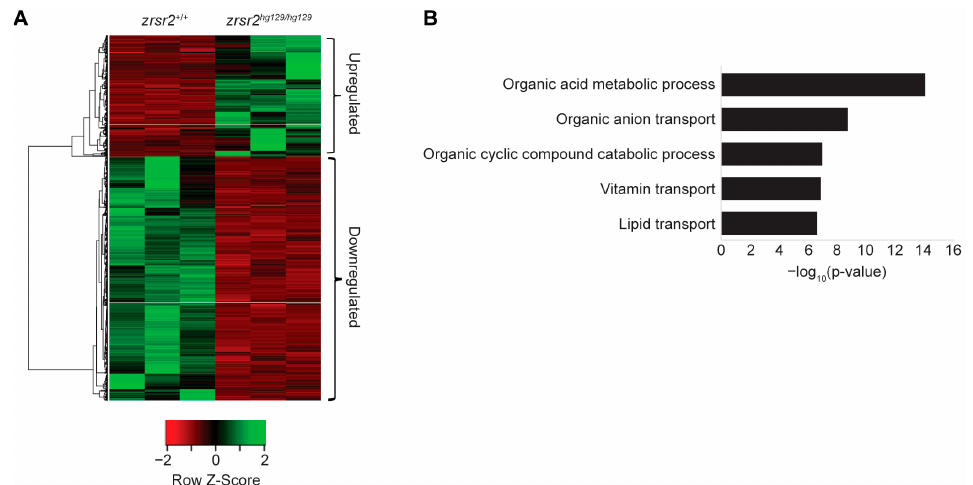
Figure 4. Loss of zrsr2 leads to global gene expression changes in metabolic processes. ( A ) Heatmap of the differentially expressed genes in zrsr2 hg129/hg129 embryos compared to their WT controls at 3 dpf, with the color key shown below the heatmap. An amount of 455 genes were upregulated, and 917 genes were downregulated in the zrsr2 hg129/hg129 samples (fold change ≥ 2, p < 0.05). ( B ) Bar graph of the top 5 biological processes enriched among 917 downregulated genes in zrsr2 hg129/hg129 embryos at 3 dpf, with enrichment visualized by − log10 ( p -value). Metabolic processes and transport of ions, vitamins, and lipids are among the most significantly enriched pathways among the downregulated genes.